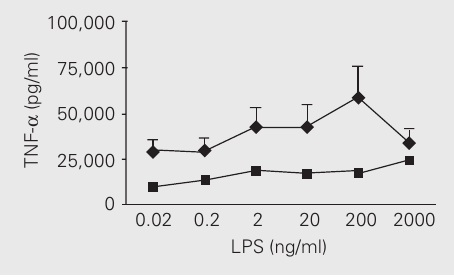
Figure 5. Dose-response rela- tionships between tumor necro- sis factor alpha (TNF- α ) produc- tion and lipopolysaccharide (LPS) stimulation in malnour- ished children and healthy con- trols. Data are reported as mean ± SEM TNF- α measurements in 24-h culture supernatants. Squares, healthy controls (N = 18); losenges, malnourished subjects (N = 11). Differences between the two groups were significant at all LPS concentra- tions except 2000 ng/ml (from 0.02 to 200 ng/ml, P values were ≤ 0.001, ANOVA with Tukey HSD